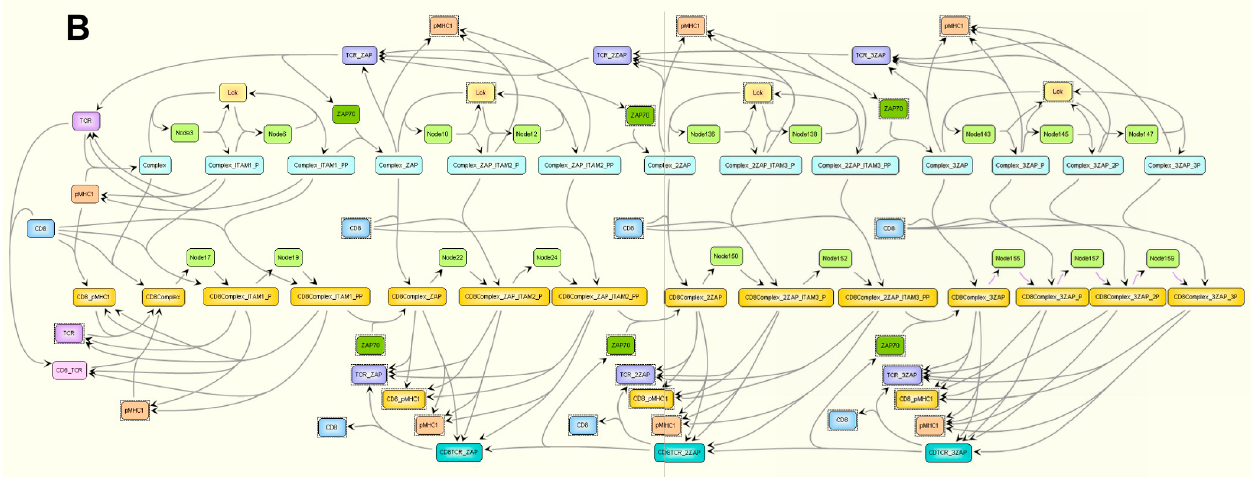
Fig 2. The model used by Altan-Bonnet and Germain of the core module of early events of TCR signaling. Image reproduced under CC-BY 4.0 license, credit: https://doi.org/10.1371/journal.pbio.0030356.